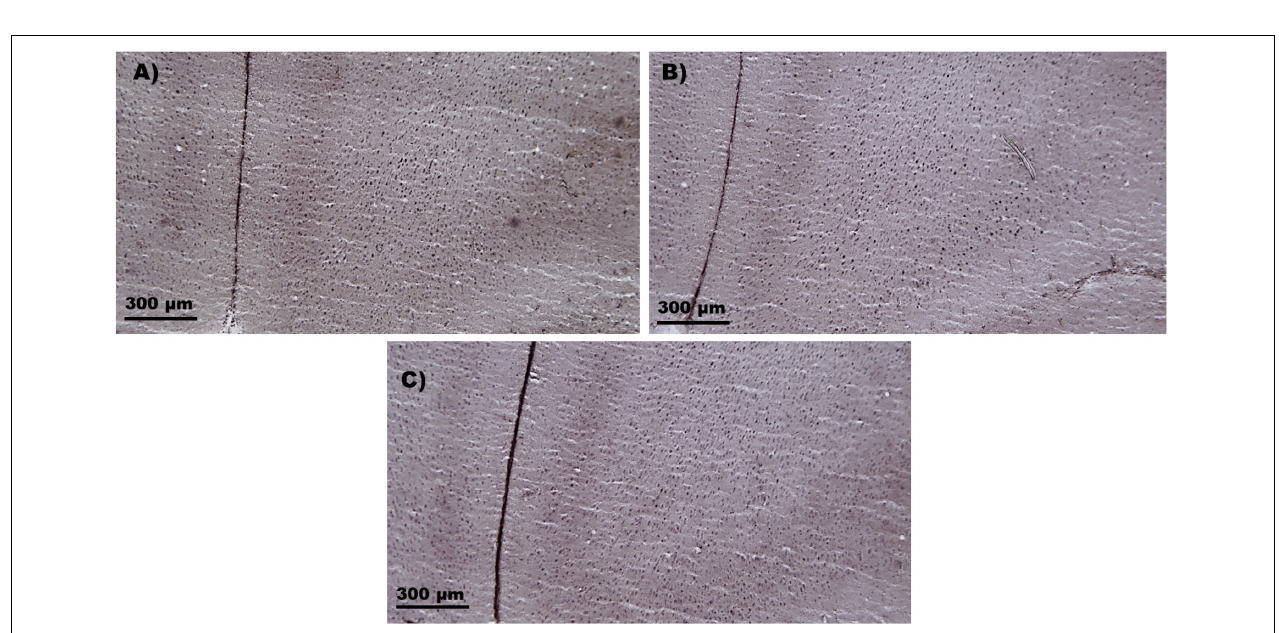
FIGURE 4 | c-Fos-positive cells (positive cells of c-Fos/ µ m 2 ) results in the regions of interest. (A) c-Fos results in 29 day-old male groups (C, PBMD, and PBM). No significant differences were found in any of the areas ( p > 0.05). (B) c-Fos results in 29 day-old female groups (C, PBMD, PBM). There were no differences between the groups in the assessed areas ( p > 0.05). Groups: C, control group; PBMD, photobiomodulation device group; PBM, photobiomodulation group. Areas: CG, Cingulate cortex; PL, Prelimbic cortex; IL, Infralimbic cortex; CA1, field CA1 of hippocampus; CA3, field CA3 of hippocampus; DG, Dentate Gyrus. PND, postnatal day.